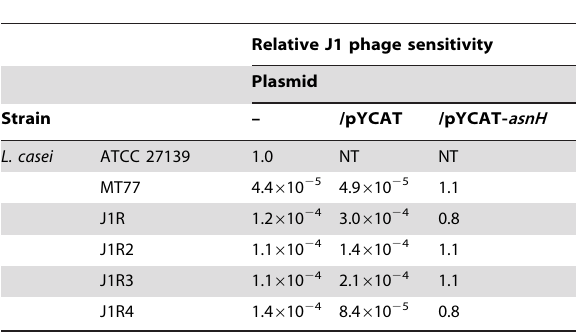
Table 3. Relative sensitivities to J1 phage infection among MNNG-induced J1 phage-resistant